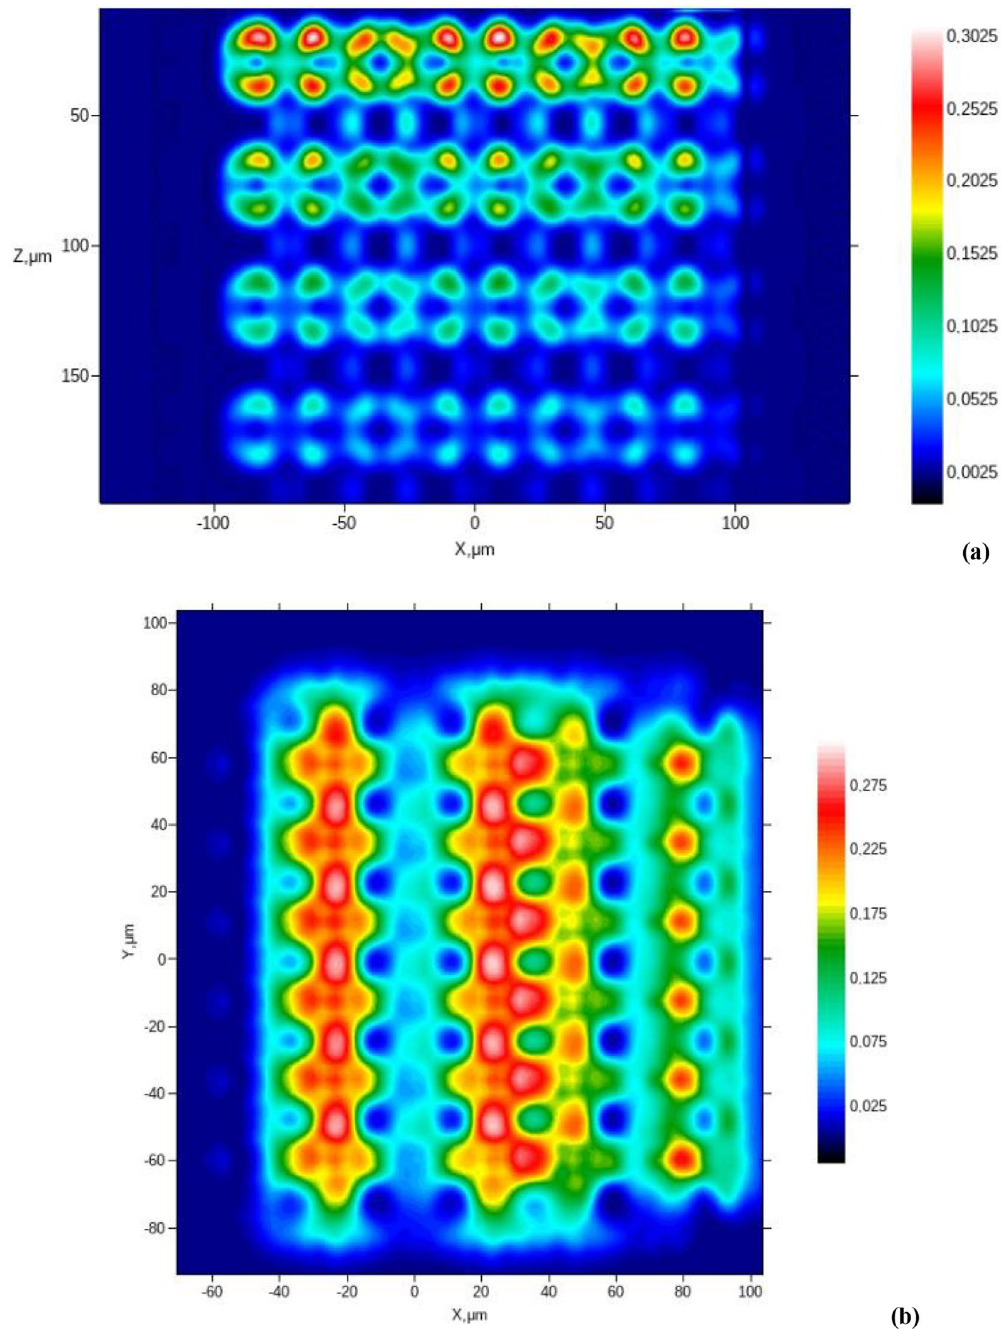
Figure 5. Results of numerical simulation of OCT-images of AT layers: ( a ) example of the B-scan for AT fragment with 8 cell-layers along the z- direction; ( b ) the C-scan (in terms of W values) of the 100 μm-depth layer for AT fragment with 8 cell-layers along the z